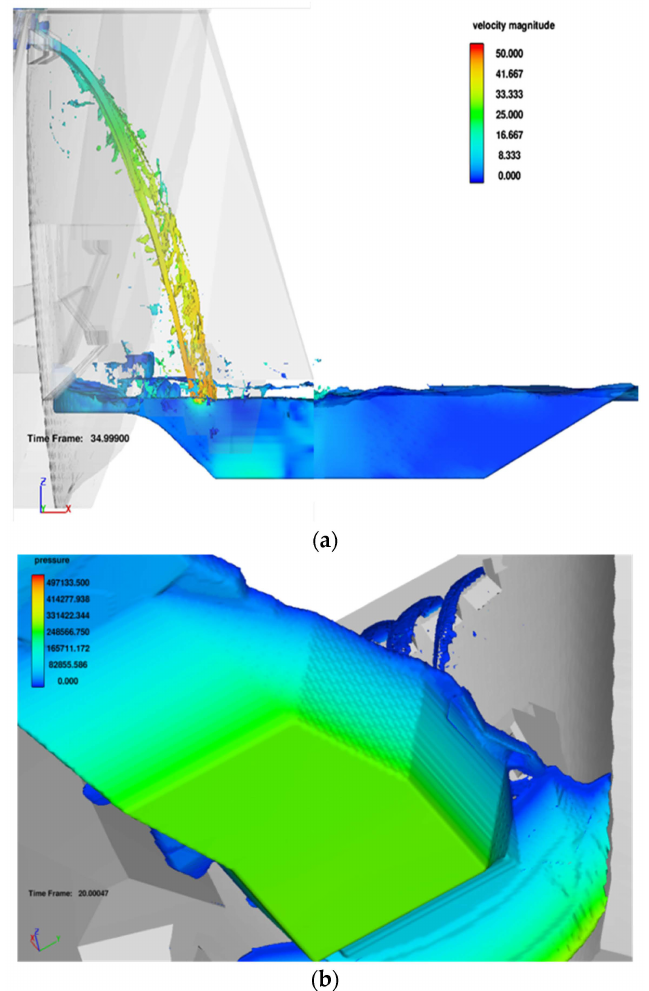
Figure 14. Lateral and spatial views of the free surface weir jets in the air and in the pre-excavated stilling basin (Prototype scale. Units in m/s and in Pascal): ( a ) Velocities; ( b ) Pressures ( Q = 700 m 3 /s).